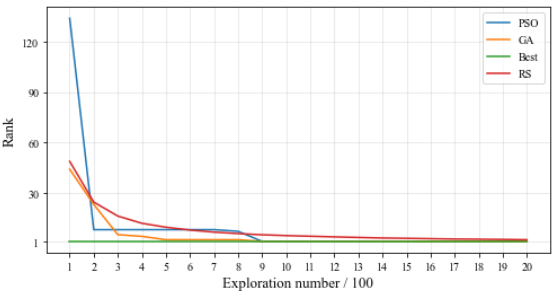
Figure 5. PMU placement ranking based on number of exploration: 33-bus system, N m = 3.